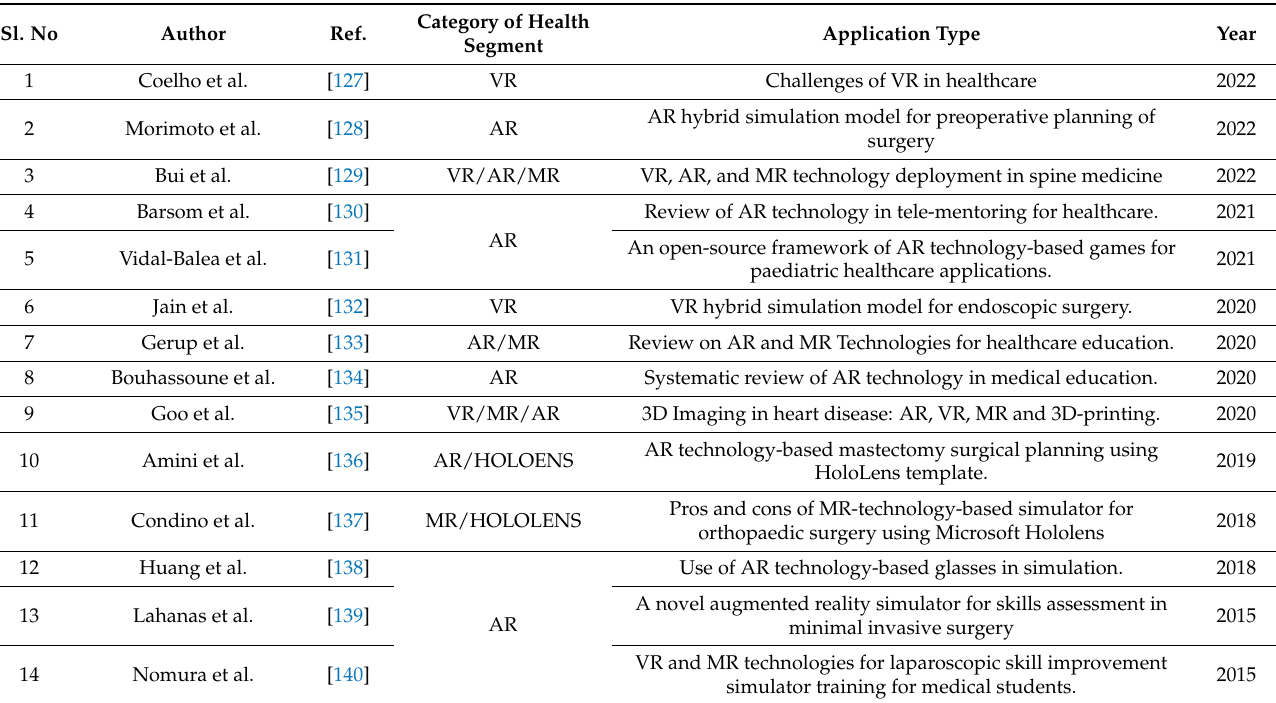
Table 6. Review of VR/AR/MR technologies’ deployment in allied medical field applications .